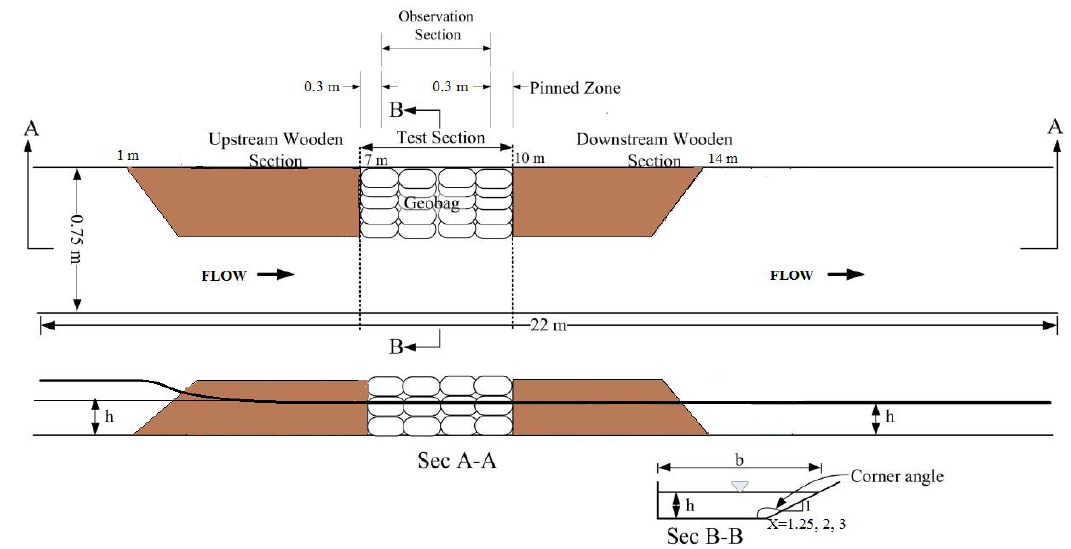
Figure 2. Experimental setup (located halfway down the flume).